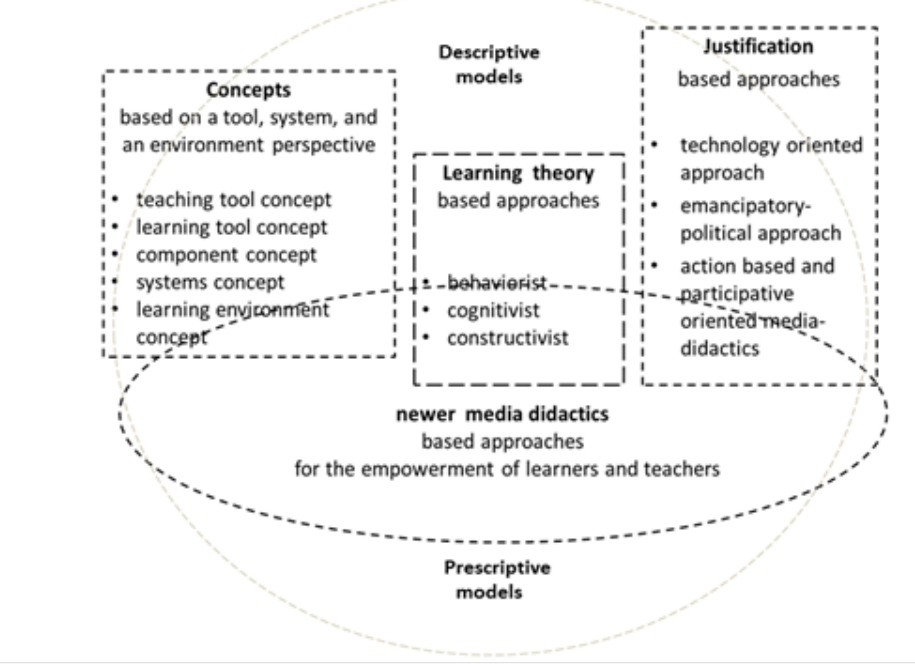
Figure 3 . Approaches in media didactics (Hillen,